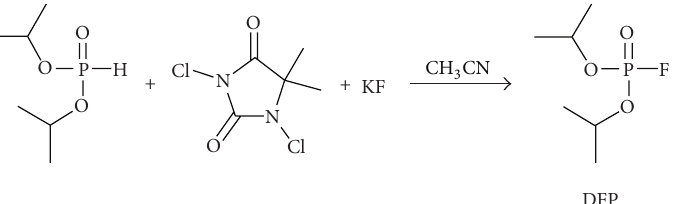
Figure 2: One-pot synthesis of DFP.